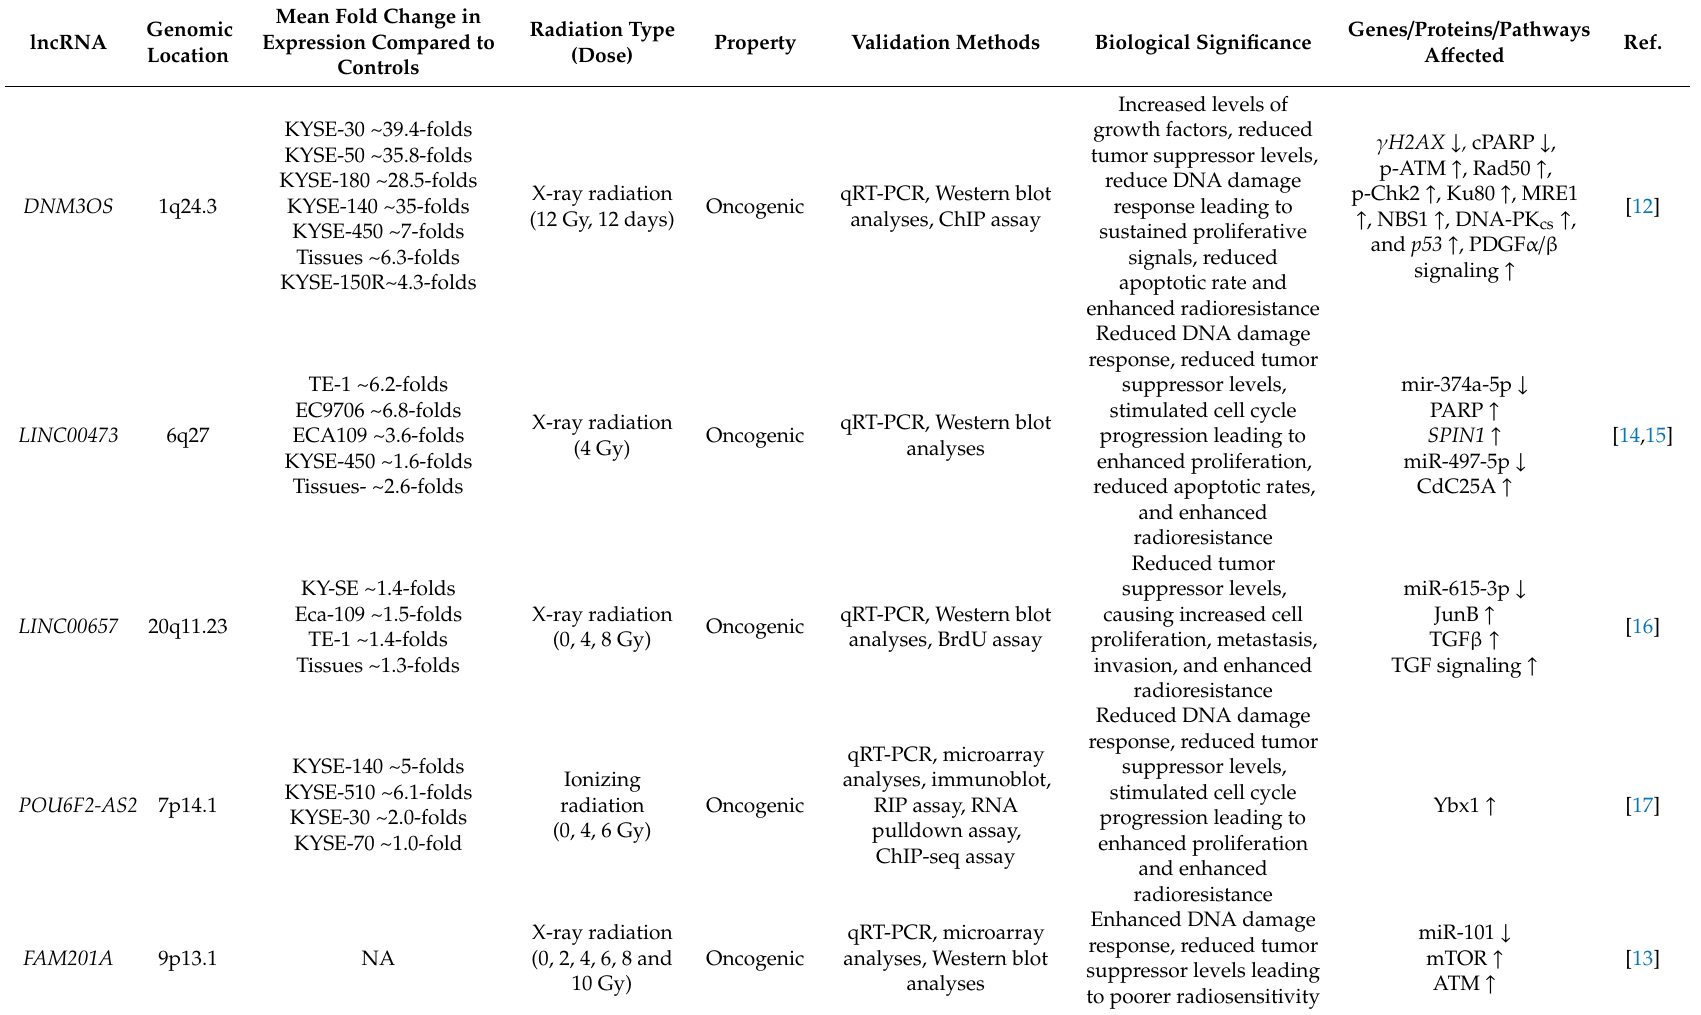
Table 1. Characteristics of lncRNA in conferring radioresistance and radiosensitivity in